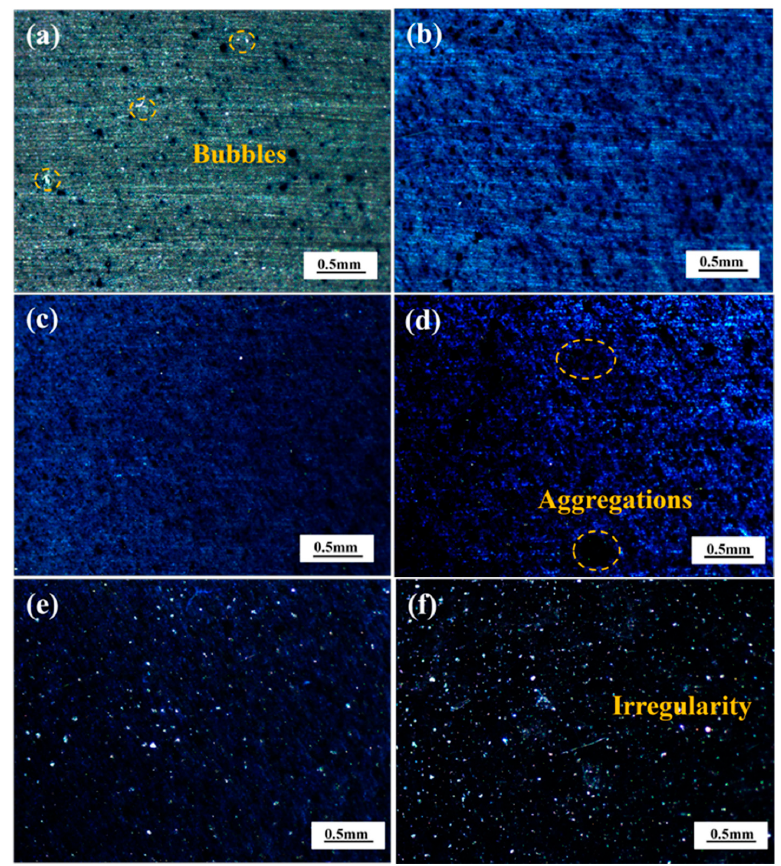
Figure 5. The stereo imaging characteristics of coatings with different content of PANI-SSA: ( a ) 0.1 wt. %; ( b ) 1 wt. %; ( c ) 2 wt. %; ( d ) 4 wt. %; ( e ) 6 wt. %; ( f ) 8 wt. %.